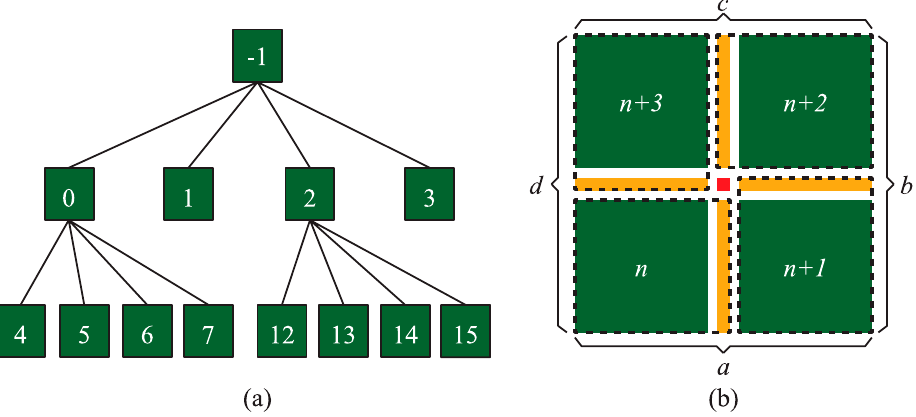
Figure 5. Indexing scheme based on quadtree: ( a ) Indices of quadtree nodes. ( b ) The Dynamic Stitching Strip (DSS) and M-block in the same dotted rectangle are bound together; 𝑎~𝑑 represent the four edges of an M-block.